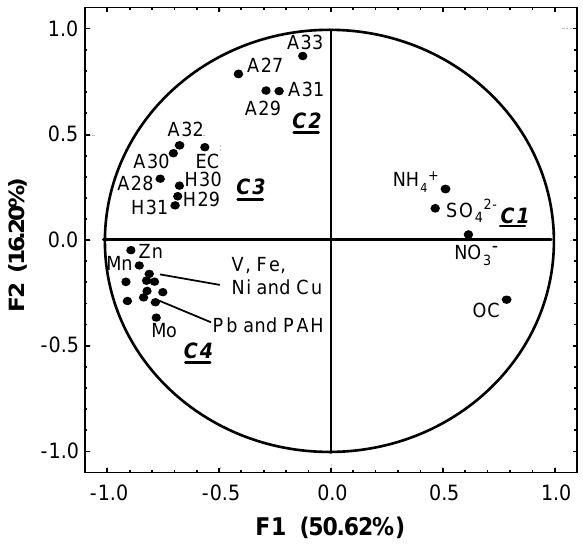
Fig. 2 Fig. 2. Principal component analysis projections of 27 vari- ables consisting of concentrations (ngm − 3 ) of 23 different markers including: a series of C27-C32 alkanes (A27-A32), 3 hopanes (17 α (H),21 β (H)-norhopane (H1), 17 α (H),21 β (H)- hopane (H2) and 22S,17 α (H),21 β (H)-homohopane (H4)), 4 PAH (benzo[b,k]fluoranthene, benzo[e]pyrene, indeno[1,2,3-cd]pyrene and benzo[ghi]perylene), a set of 8 elements (V, Mn, Fe, Ni, Cu, Zn, Mo and Pb), and EC, as well as OC and the 3 major ions (NH + , 4 ) . F1 and F2 denote the first and the second princi- NO − , SO 2 − 3 4 pal components, respectively. C1, C2, C3 and C4 are the 4 clusters obtained by the